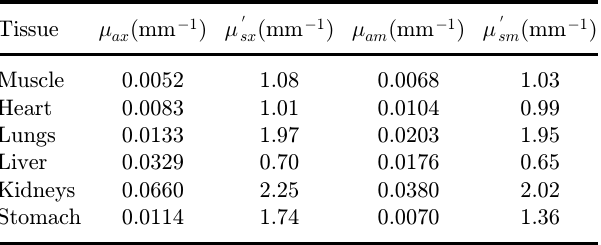
Table 1. Optical parameters of the mouse organs (highly scatter).